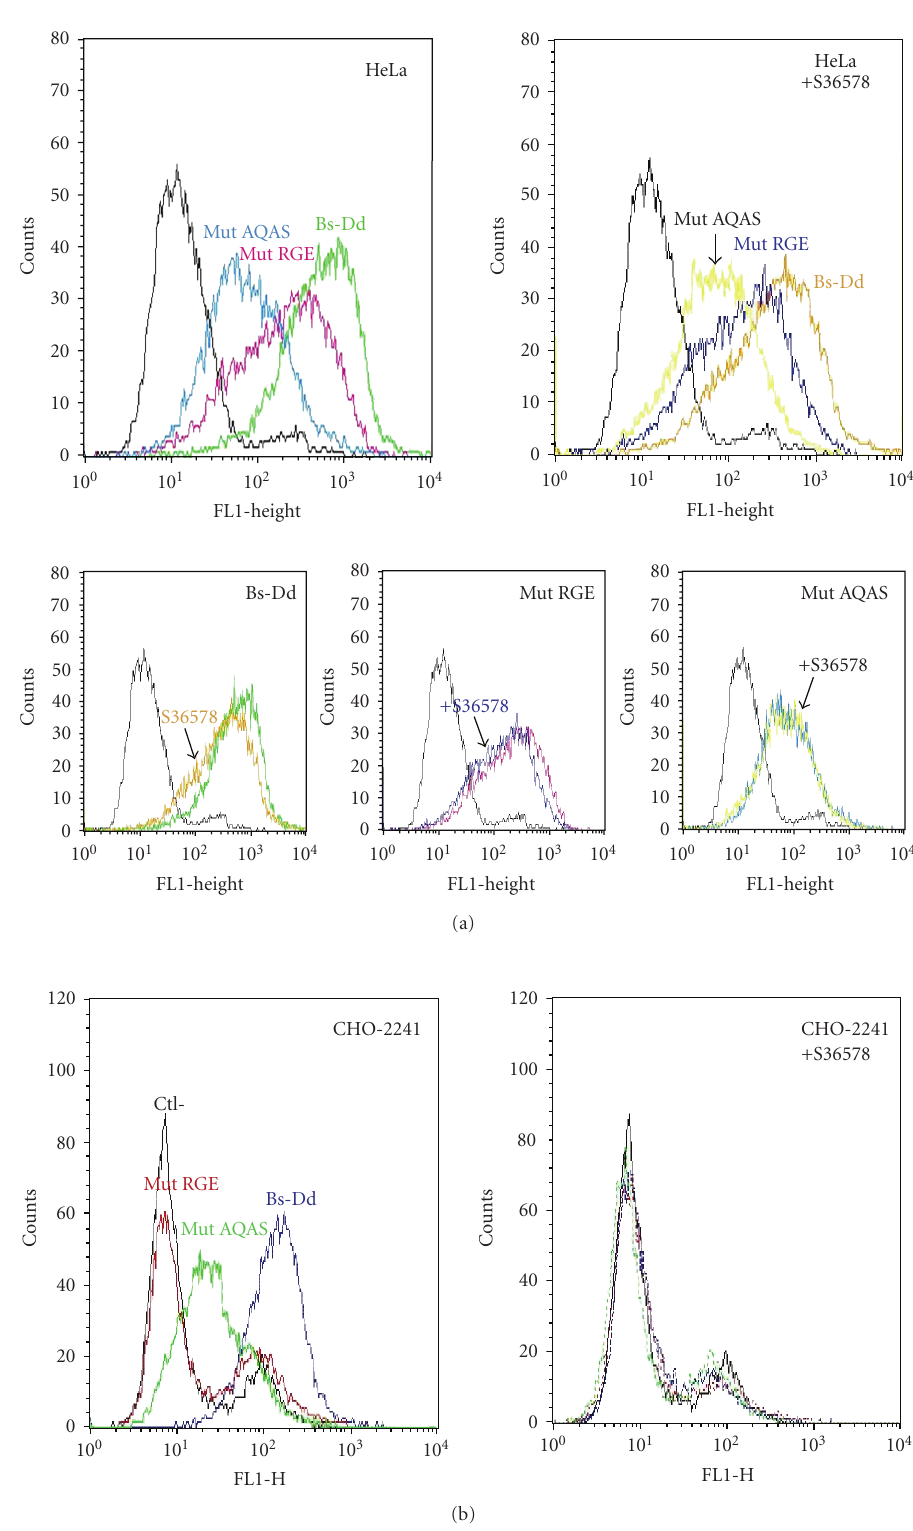
Figure 3: FACS analysis of Bs-Dd and mutant binding at 4 ◦ C to HSPG expressing HeLa cells and HSPG deficient CHO-2241. (a) Particle binding to HeLa cells. Dodecahedra (wt or mutants) were incubated with HeLa cells in PBS 1 mM CaCl 2 preincubated or not with S36578 drug (upper right and left panels, resp.). Lower panels show individual responses of the di ff erent mutants with or without S36578. (b) Particle binding to CHO-2241 cells under the same conditions used above. Dodecahedra were allowed to bind to CHO-2241 cells preincubated or not with S36578 drug (right and left panels, resp.). Bound particles were detected by an antibody serum directed against the Ad3 penton